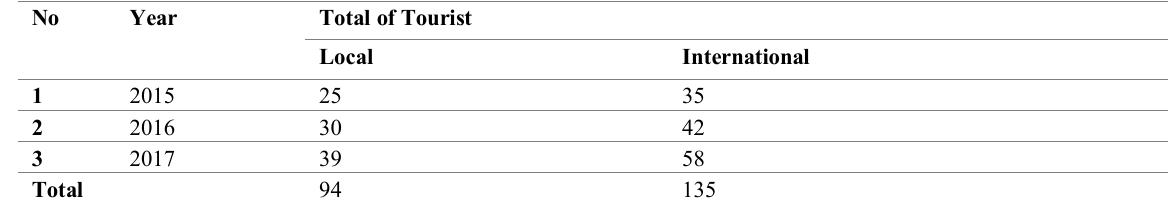
Table 2: Tourist visit in Lempur rural tourism,